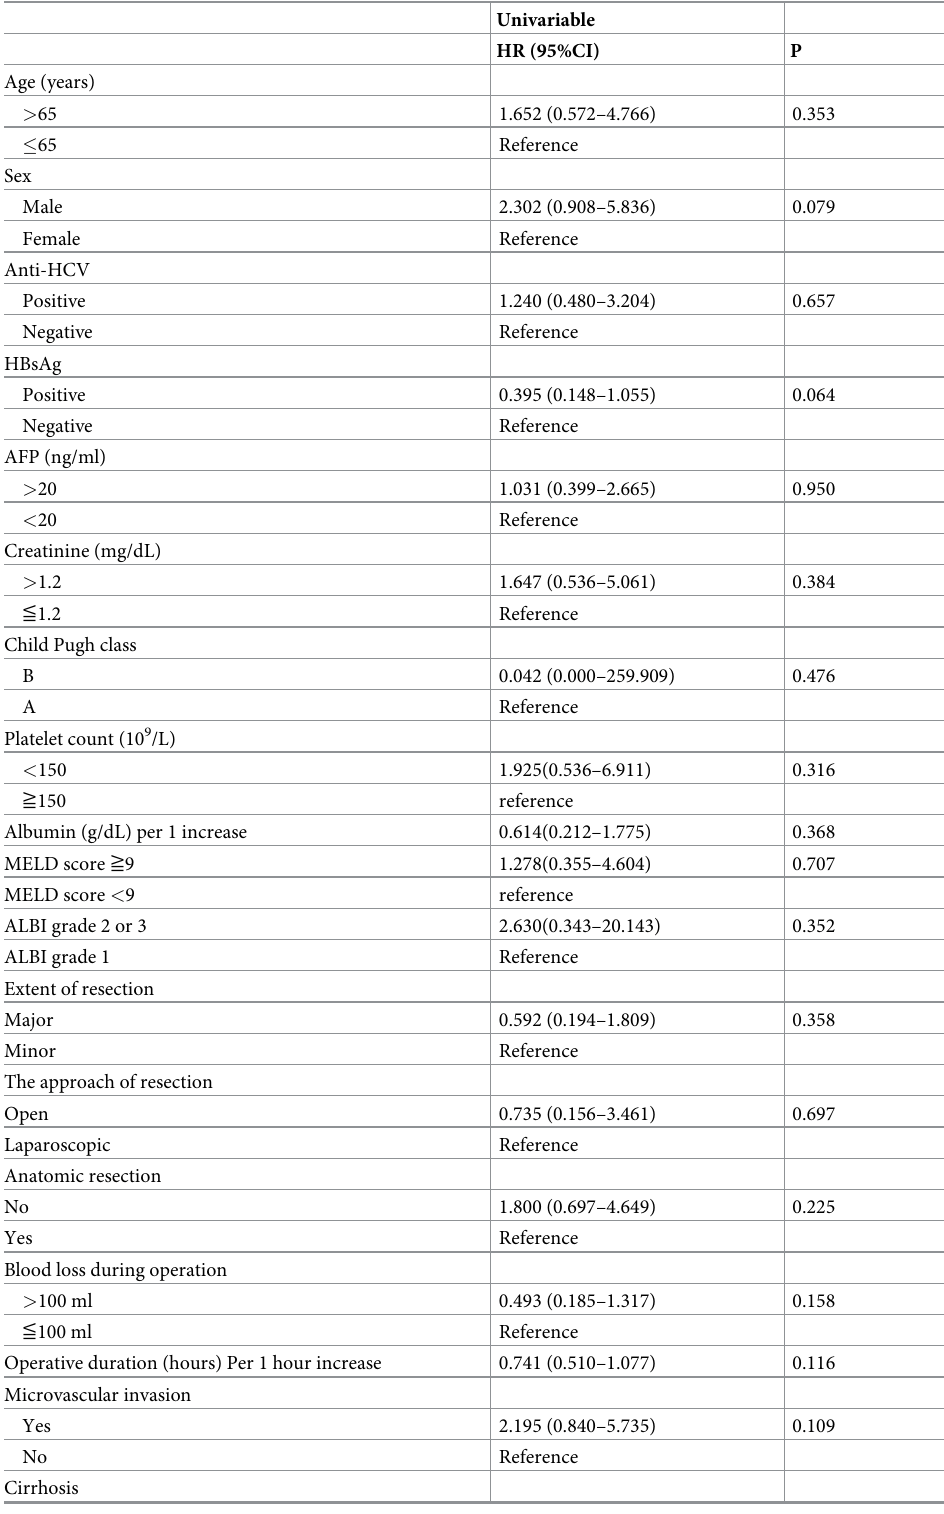
Table 2. Univariate analysis of overall